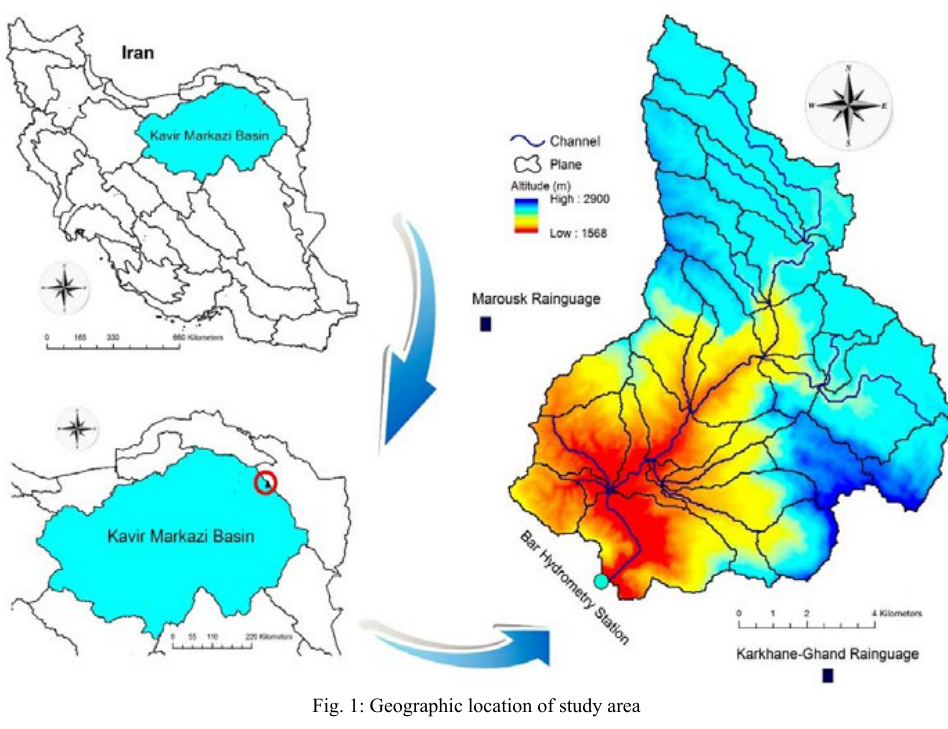
Fig. 1: Geographic location of study area